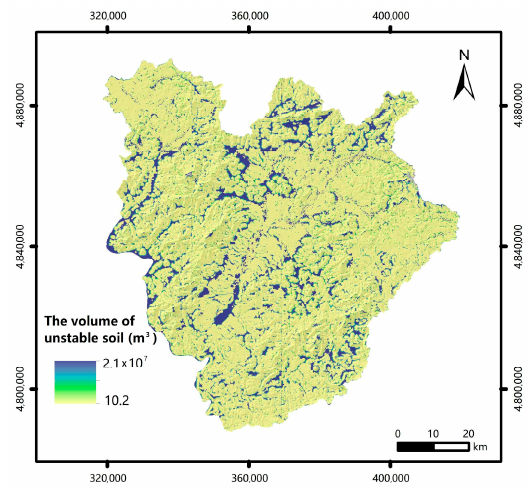
Figure 7. The volume of unstable soil mass in Jiaohe County using the Scoops3D model.